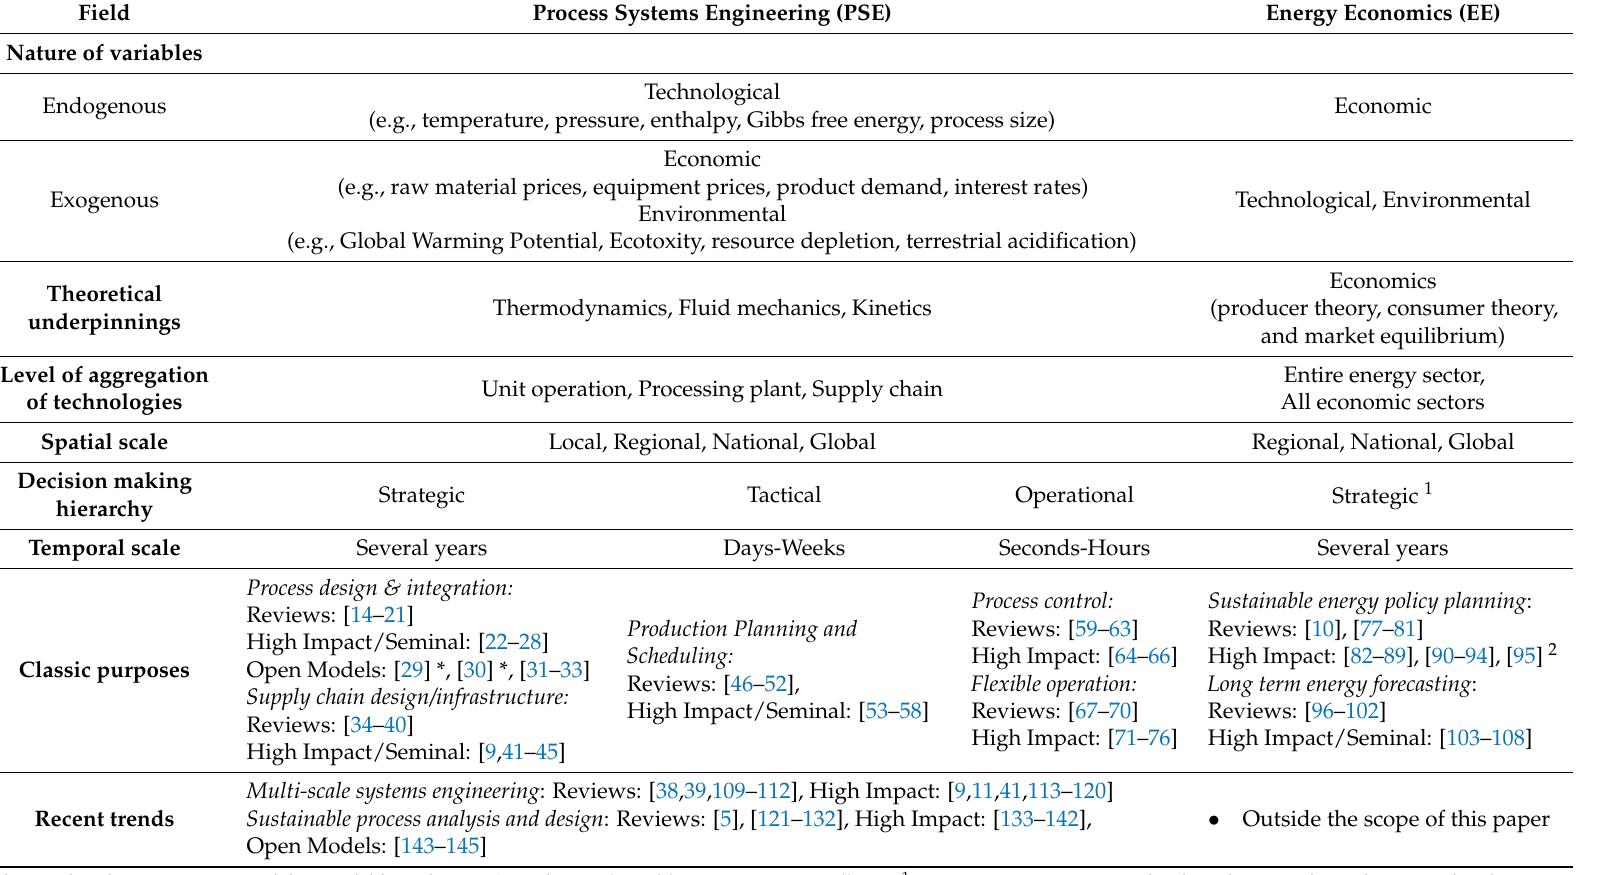
Table 1. Classification of energy system models according to